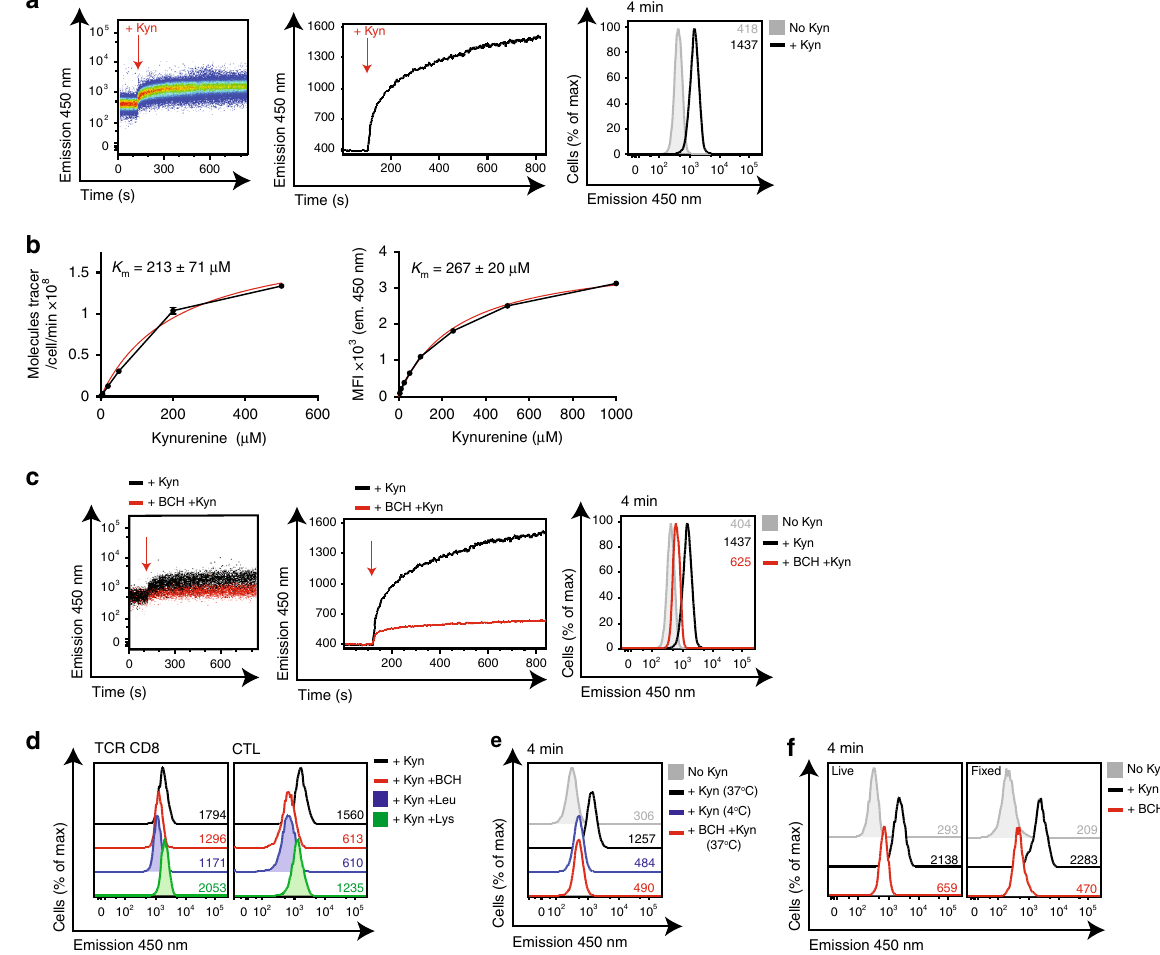
Fig. 2 Flow cytometric monitoring of System L-dependent kynurenine uptake. a Flow cytometric evaluation of kynurenine uptake in IL-2 maintained CTLs. Data acquired using 405 nm excitation (violet laser) and band pass fi lter 450 ± 50 on BD LSRII (Fortessa). The left panels show a dot plot of fl uorescence (emission 450 nm) of CTLs against time. Data acquired pre (120 s) and post ( + 700 s) addition of 200 μ M kynurenine (indicated by red arrow). The centre panel shows the same data plotted as a geometric mean trace (FlowJo software). The right panel shows overlaid histograms of the data from CTLs in the presence or absence of kynurenine (200 μ M) for 4 mins (37 °C). b The graphs show the number of 3 H-kynurenine molecules transported per cell per minute (left), or mean fl uorescence intensity (MFI, right) of IL-2 maintained CTLs when incubated with increasing kynurenine concentrations. K m values, the concentration of kynurenine that gives half maximal uptake, were calculated using standard Michaelis – Menton equation (GraphPad Prism software). c 450 nm fl uorescence in IL-2 maintained CTLs treated with kynurenine, as in a , in the presence or absence of the System L inhibitor, BCH (10 mM). d 450 nm fl uorescence emission of 36 h CD3/CD28 stimulated CD8 + T cells (left) or IL-2 maintained CTLs (right) treated with kynurenine in the presence or absence of BCH (10 mM), Leu (5 mM) or Lys (5 mM) at (37 °C) for 4 min. e 450 nm fl uorescence emission of IL-2 maintained CTLs treated with kynurenine in the presence or absence of BCH (10 mM), at (37 °C); or treated with kynurenine at (4 °C) for 4 min. f The histograms show 450 nm fl uorescence in CTLs treated with kynurenine for 4 mins ± BCH (10 mM). Cells were analysed immediately (live; top panel) or after fi xation ( fi xed; bottom panel) using 1% paraformaldehyde. MFIs are indicated in the histograms. Data shown are representative of 6 (CTL) or 4 (TCR) experiments